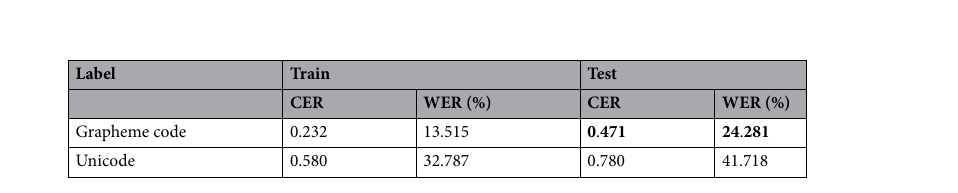
Table 7. Experimental results of Unicode and grapheme code comparison. Significant values are in [bold].